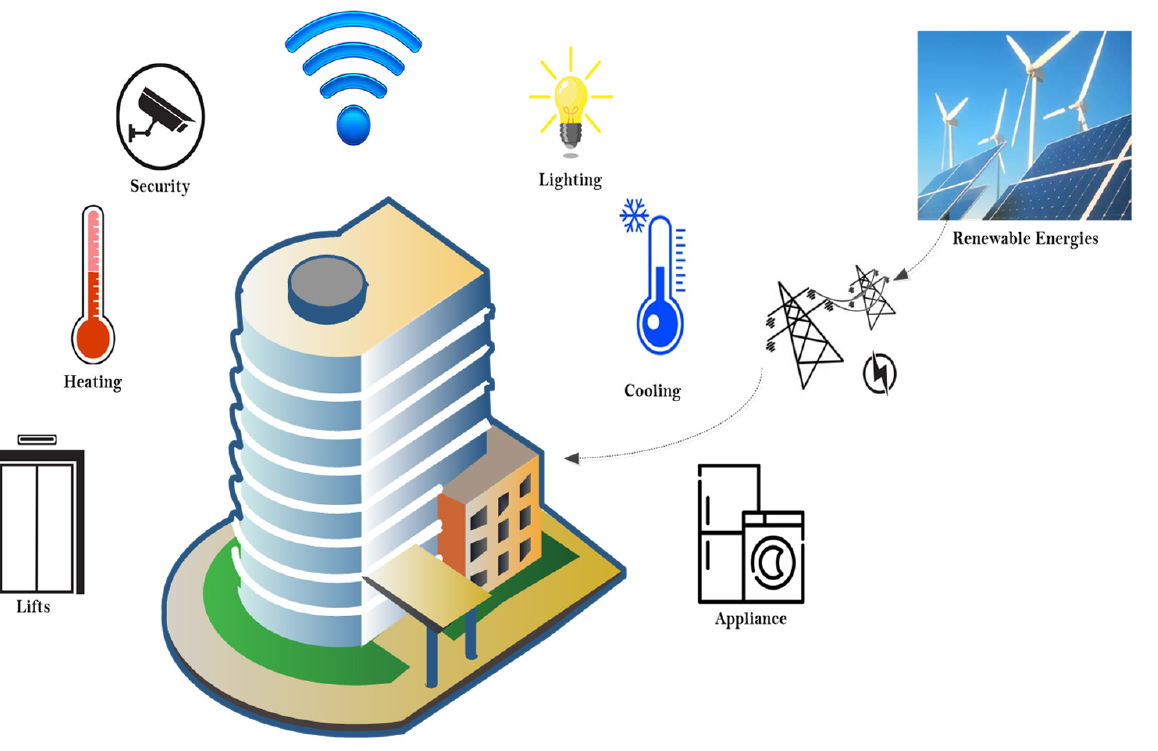
Figure 1. The overview of the building with internet-controlled loads.